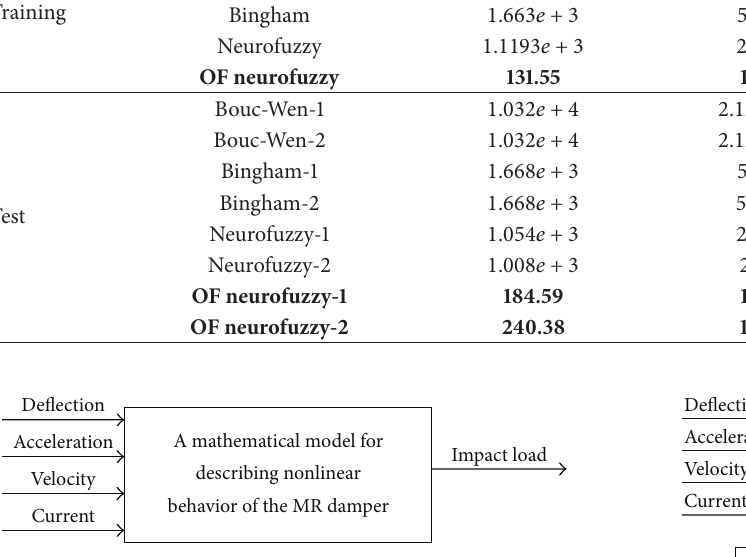
Figure 14: Configuration of the neurofuzzy model: impact load prediction.